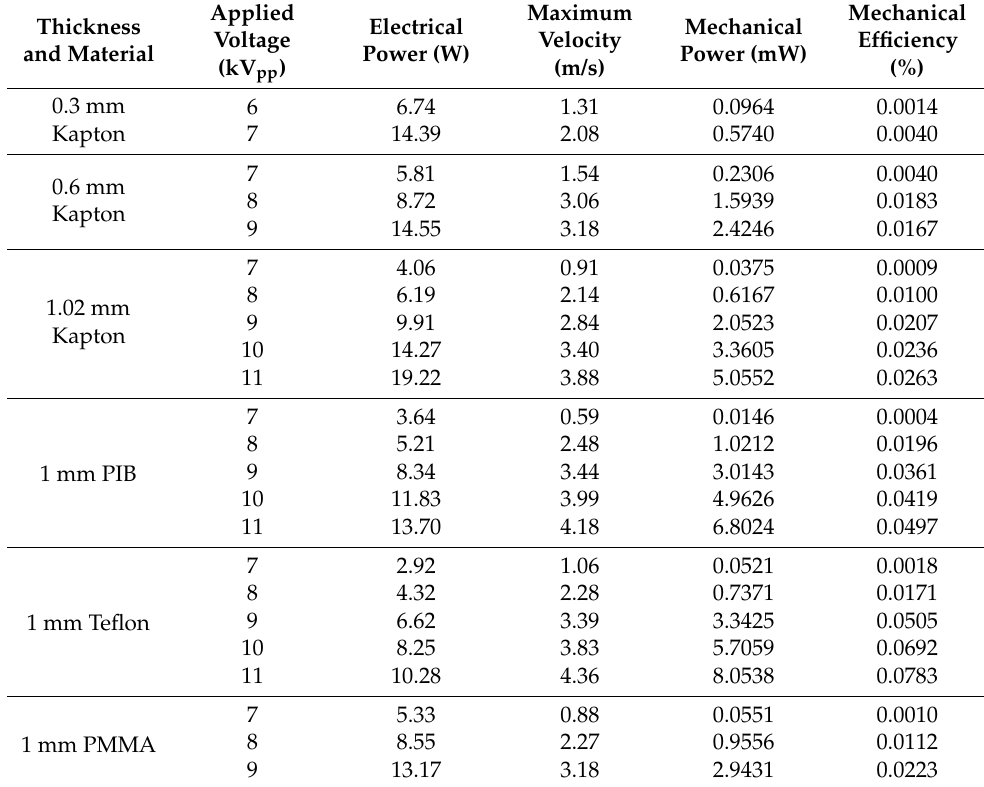
Table 2. Comparison between the thermocouple temperature measurements and the reconstructed temperature field obtained by the BOS